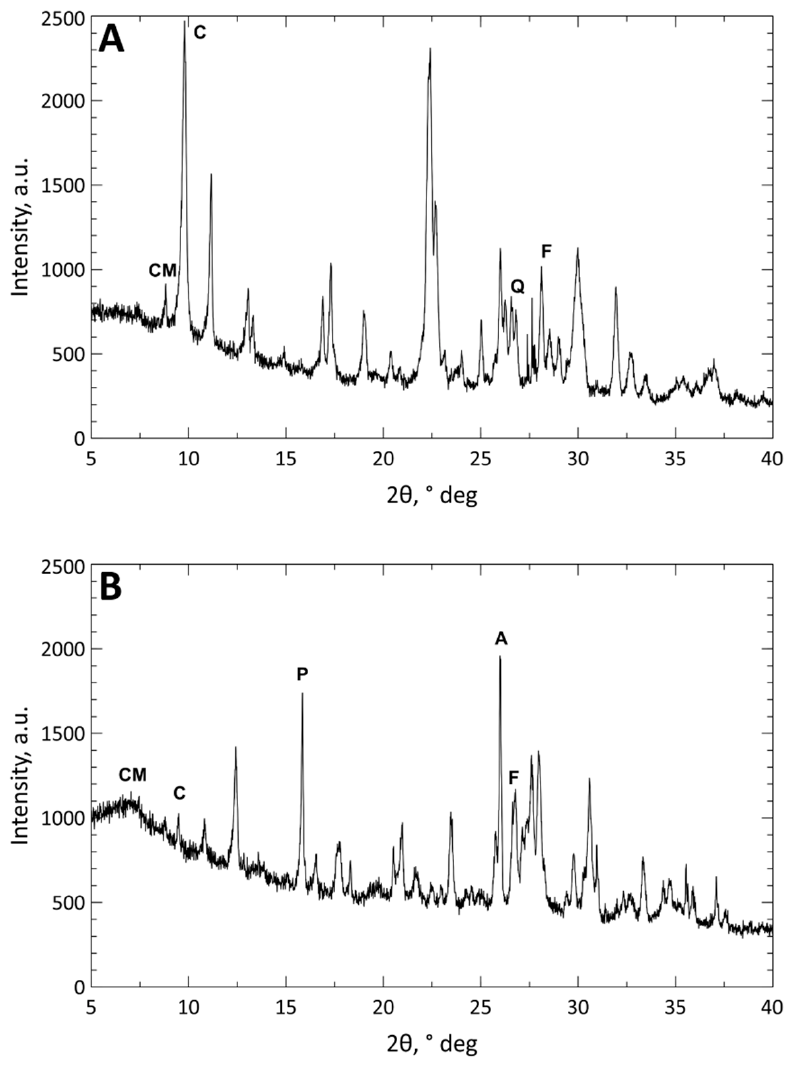
Figure 2 . XRPD characterization of clinoptilolite-rich tuff (CLI) ( A ) and phillipsite-rich tuff (PHI) sample ( B ). CM = Clay Minerals, C = Clinoptilolite, P = Phillipsite, F = feldspar, Q = quartz, A = analcime.